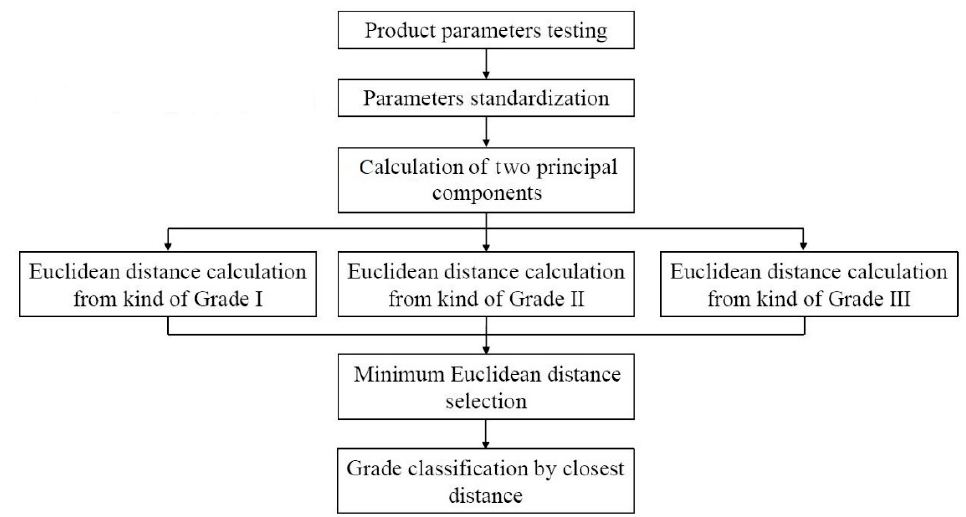
Figure 4. Flow chart for model verification. Table 18. Euclidean distances between new samples’ principal components and the average val- ues for each grade.